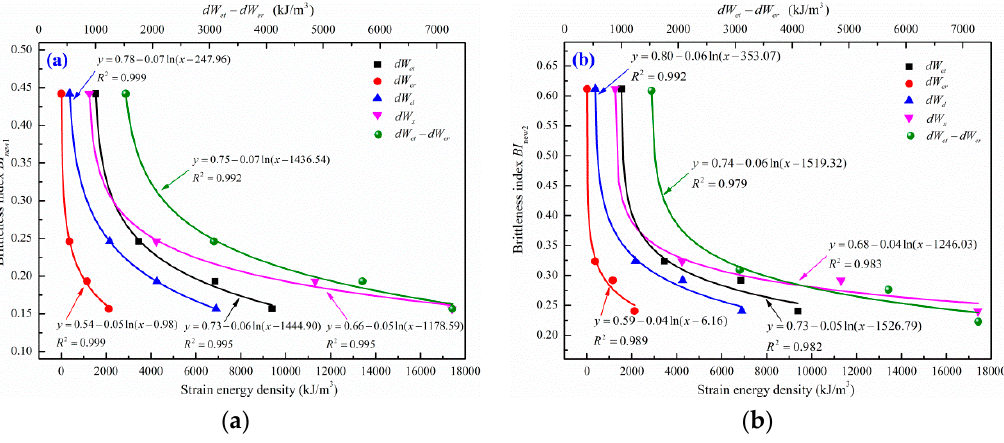
BI and ( b ) BI 1 new 2 new